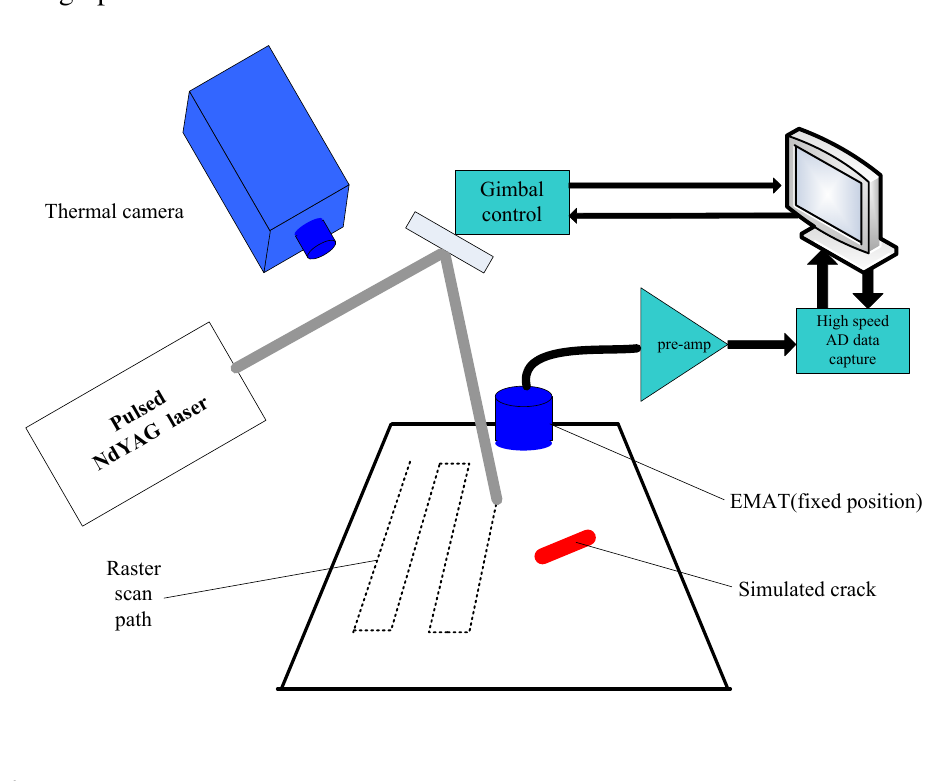
Figure 31. Schematic diagram of the experimental set-up used for non-contact ultrasonic and thermographic